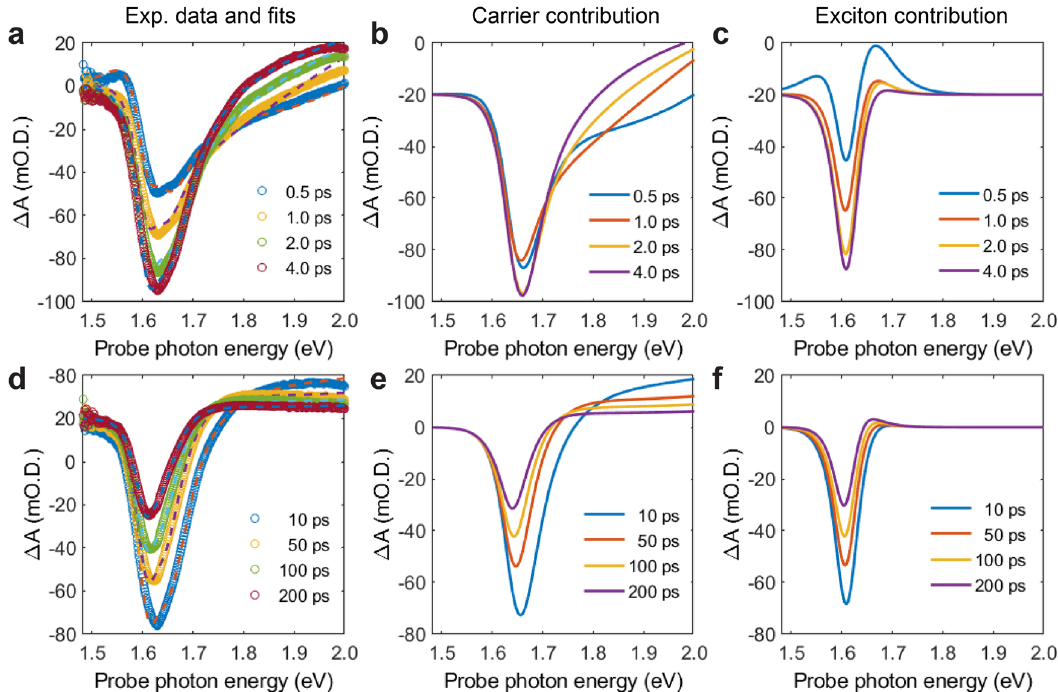
Fig. 3 Disentanglement of carrier and exciton components. Transient absorption (TA) spectra Δ A ( ℏ ω ) for experimental data (circles) and fi ts (dashed lines) ( a – c ) at short time delays and ( d – f ) long time delays for 400-nm pump. Carrier contribution [CC] term and exciton contribution [EC] term are shown in b , e and c , f , respectively. Δ A ( ℏ ω ) is the transient change of the absorption spectrum at certain pump-probe time delays with respect to the steady-state one. ℏ is the reduced Planck constant and ω is the photon frequency. O.D. is the optical density, as de fi ned in Fig. 1.